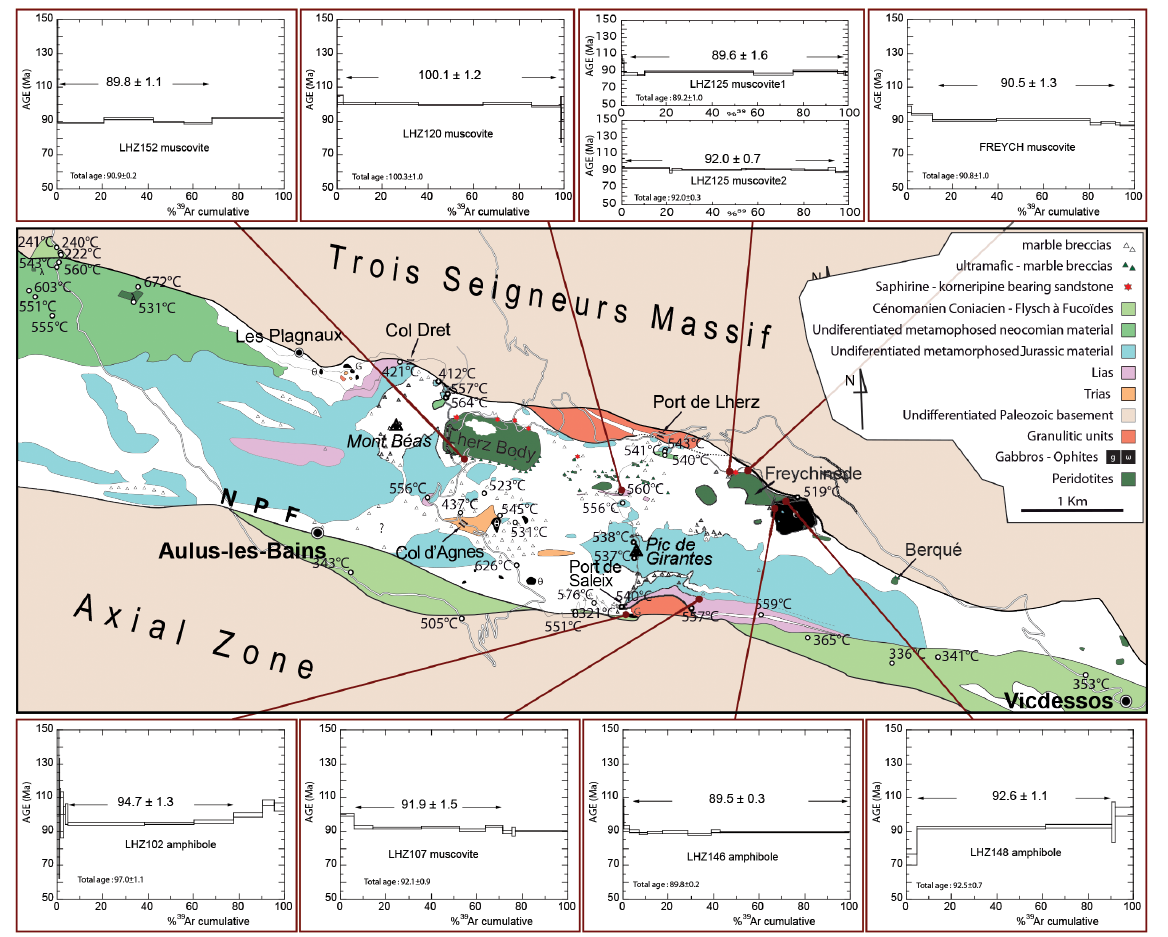
Figure 8. Geological map of the central-eastern part of the Aulus basin, with Raman temperature values and location of samples used for 40 Ar– 39 Ar dating. No clear thermal trend can be deciphered in the basins, which we interpret as an indication of post-peak-metamorphism disruption of the sedimentary